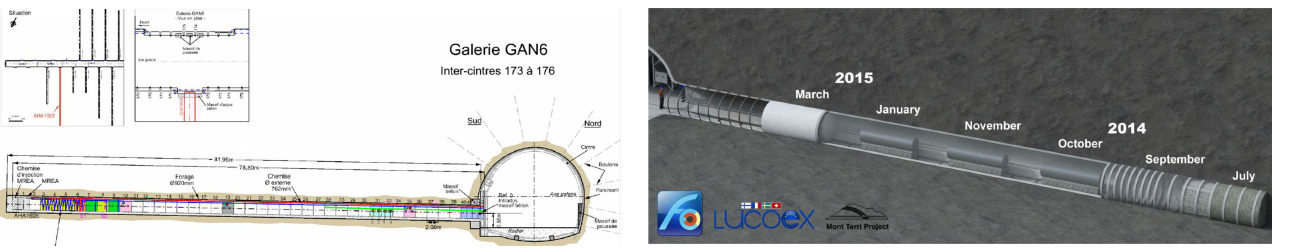
Fig. 9. Scheme of the AHA1605 in situ HLW disposal cell demonstrator in Bure URL (Andra).